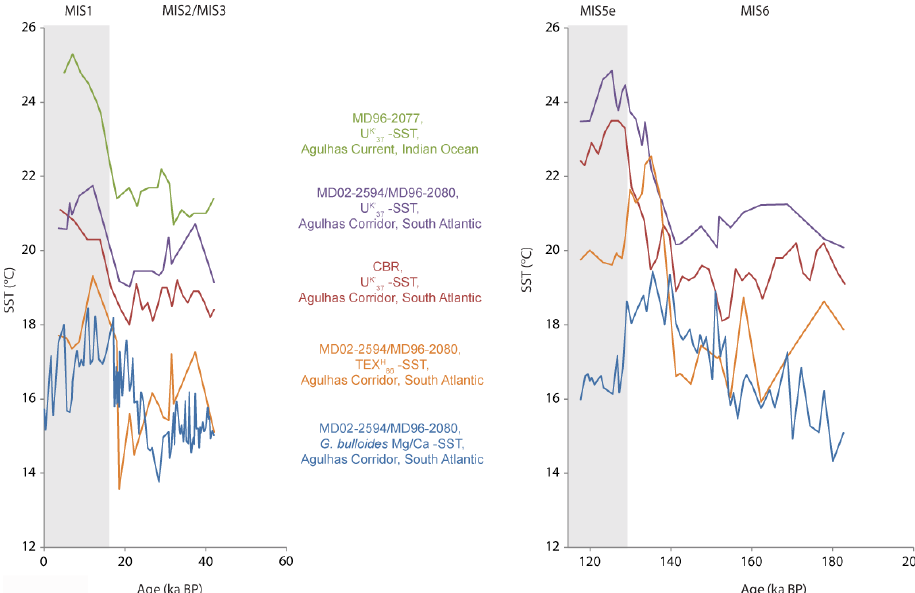
Fig. 4. Comparison of U K’ SST, TEX H SST and G. bulloides Mg / Ca SST (Martinez-Mendez et al., 2010) of (a) MIS3-1 (MD02-2594) 37 86 and (b) MIS6-5 (MD96-2080) (see Fig. 1 for core location) with U K’ SST of MD96-2077 in the Agulhas Current, Indian Ocean (Bard and 37 Rickaby, 2009) and U K’ SST of Cape Basin record in the Agulhas corridor, South Atlantic (Peeters et al., 2004). 37